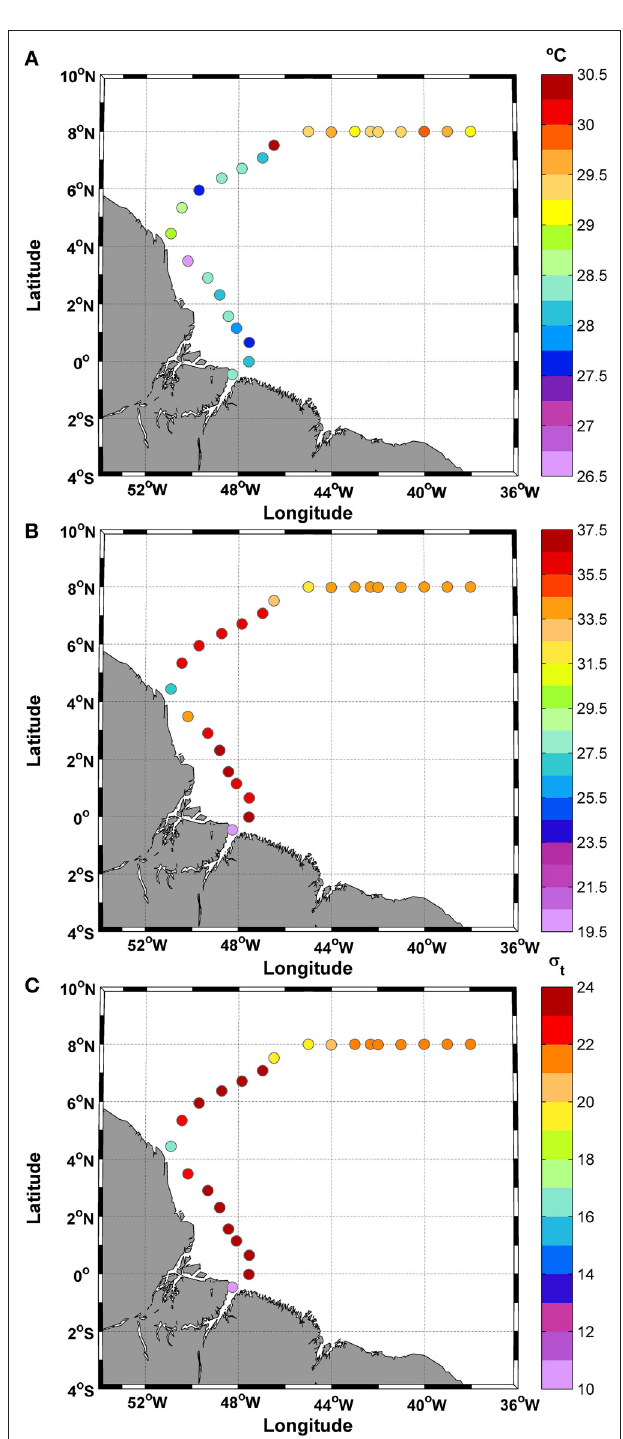
FIGURE 2 | Distribution of (A) SST; (B) SSS; and (C) σ -t along the ship track during the CF3 cruise, October 2012.